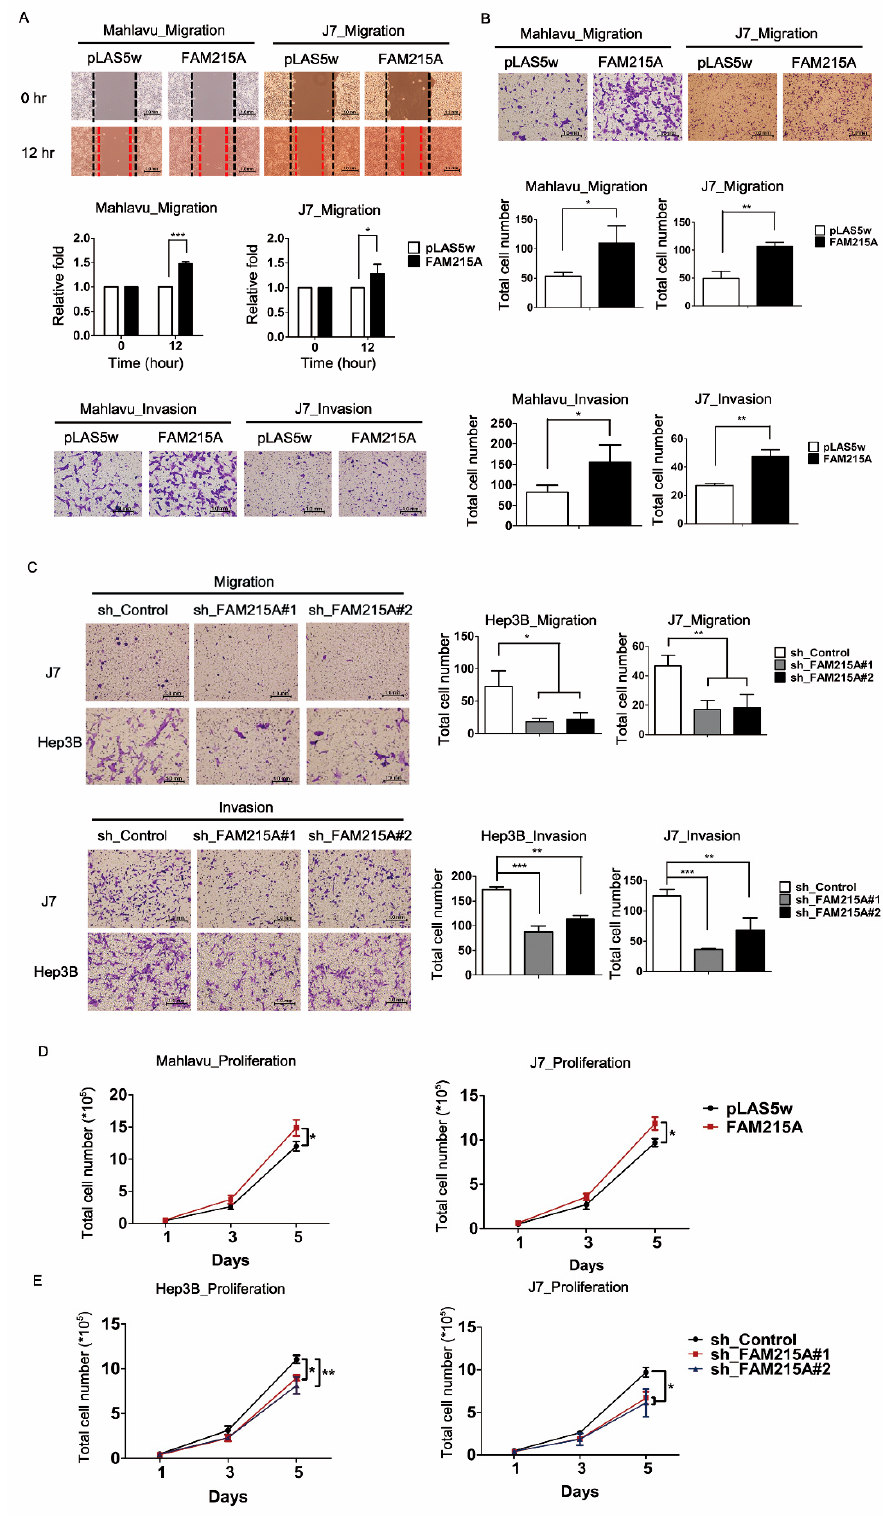
Figure 2. FAM215A promotes cell metastasis and proliferation in HCC. Migration and invasion capacity in FAM215A-expressing or depletion cells were determined by ( A ) Wound healing assay, ( B ) Transwell assay in Mahlavu and J7 cell lines. ( C ) Migration and invasion ability assayed by transwell in Hep3B and J7 cell lines. ( D , E ) Proliferation rate measured by the total cell numbers (1-5days). Data are presented as means ± SD of three independent experiments (*, p < 0.05; **, p < 0.01; ***, p < 0.001).